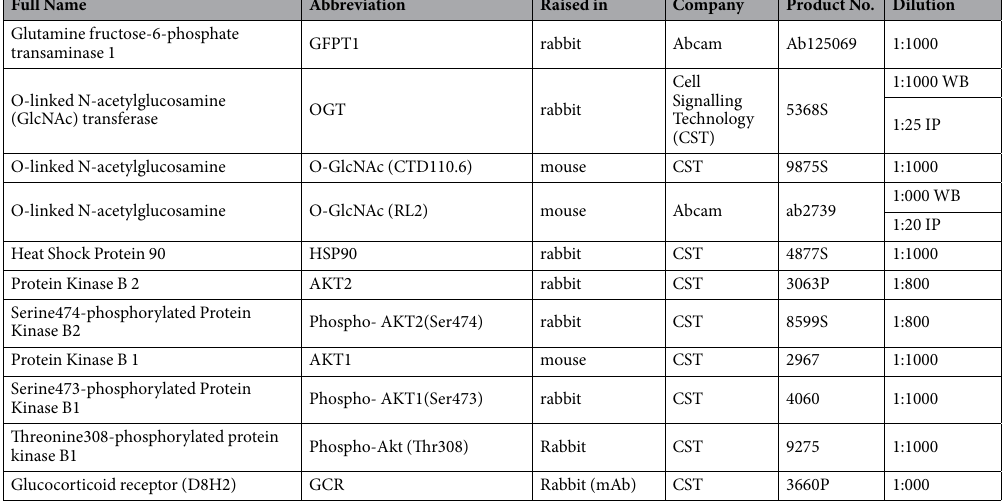
Table 1. Antibodies used for immunoblotting and